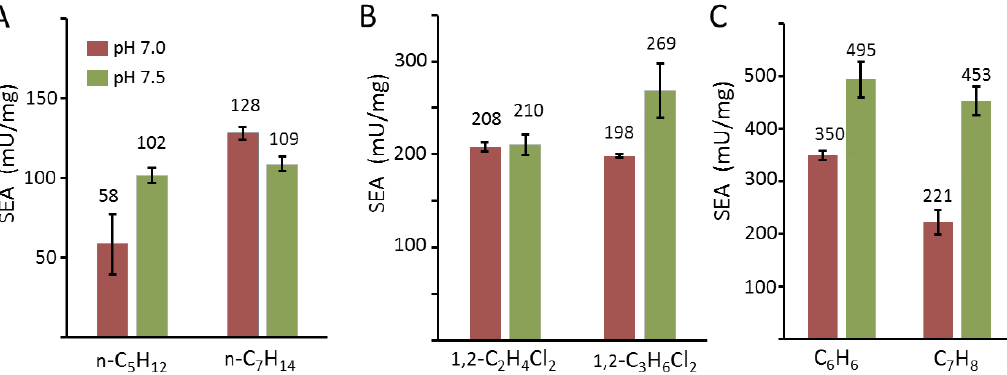
Figure 7. Soluble MMO from M. sporium 5 oxidized various substrates, including alkane, halogen, and aromatic compounds. ( A ) Normal pentane (n-C 5 H 12 ) and normal heptane (n-C 7 H 14 ) harbor more carbon atoms than propylene. The activities were measured at 340 nm by measuring NADH degradation. ( B ) Halogen compounds, including 1,2-dichloroethane (1,2-C 2 H 4 Cl 2 ) and 1,2- dichloropropane (1,2-C 3 H 6 Cl 2 ), were oxidized by sMMO. ( C ) Measurement of specific enzyme activity with benzene (C 6 H 6 ) and toluene (C 7 H 8 ). NADH consumption was not observed in the absence of substrates. SEA represents specific enzyme activity (n = 3, avg ± s.d.).